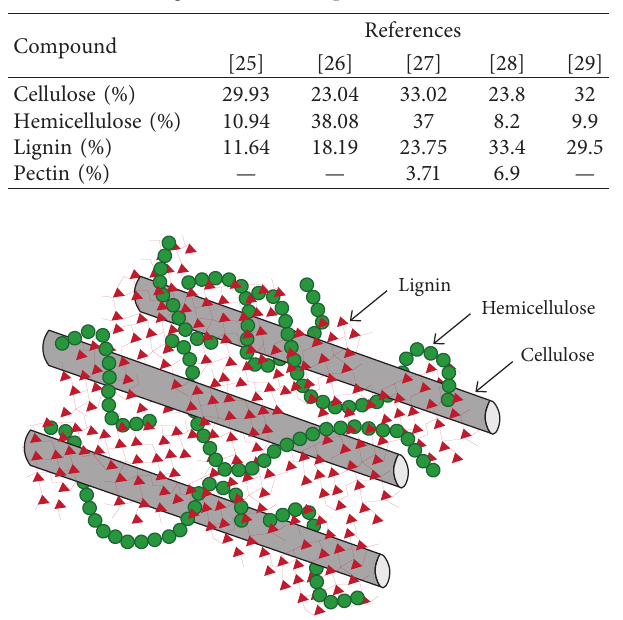
Figure 2: Structure of lignocellulose and interaction between cellulose, hemicellulose, and